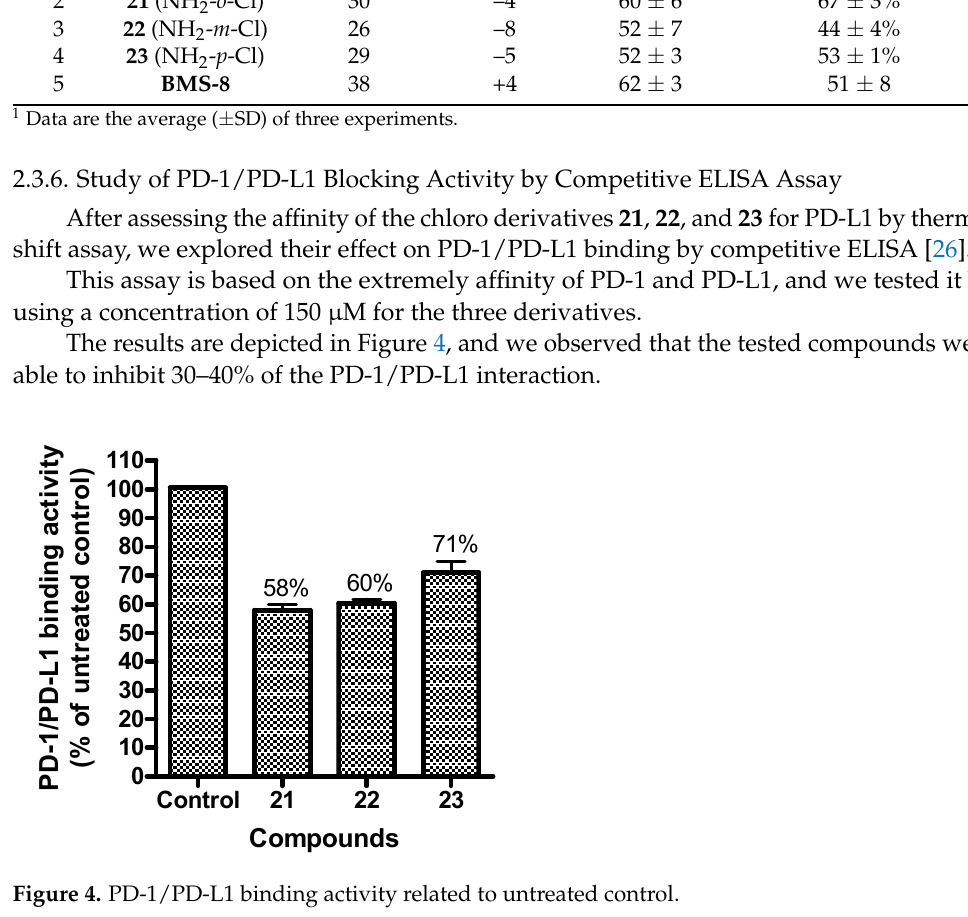
Table 6. Kinase activity for 21–23 measured in HT-29 cell cultures 1 . Entry